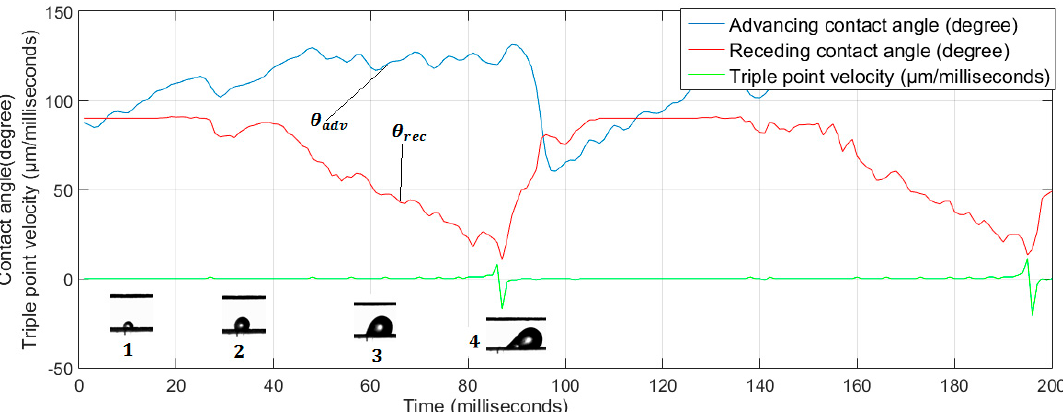
Figure 21. Water droplet images and corresponding evolution of θ adv , θ rcd , and TPV: (1) at droplet emergence, (2) droplet growth, (3) onset of droplet deformation, (4) detachment.